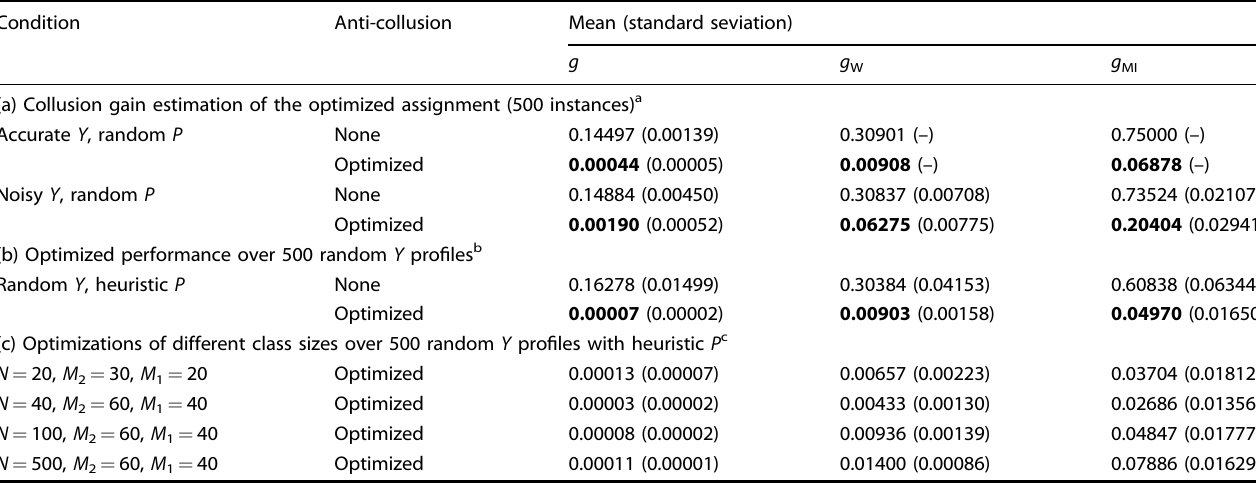
Table 1. Collusion gain estimation and optimization in the case of N = 85, M 2 = 60, M 1 = 40, and Q = 4.